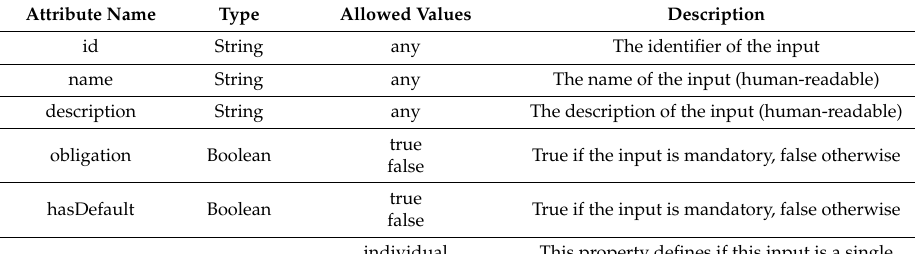
Table 2. Attributes of VLab BPMN Extension for Input and Output